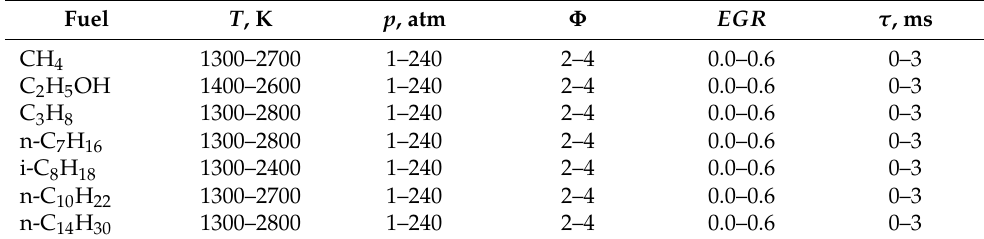
Table 1. The list of conditions included in the database.